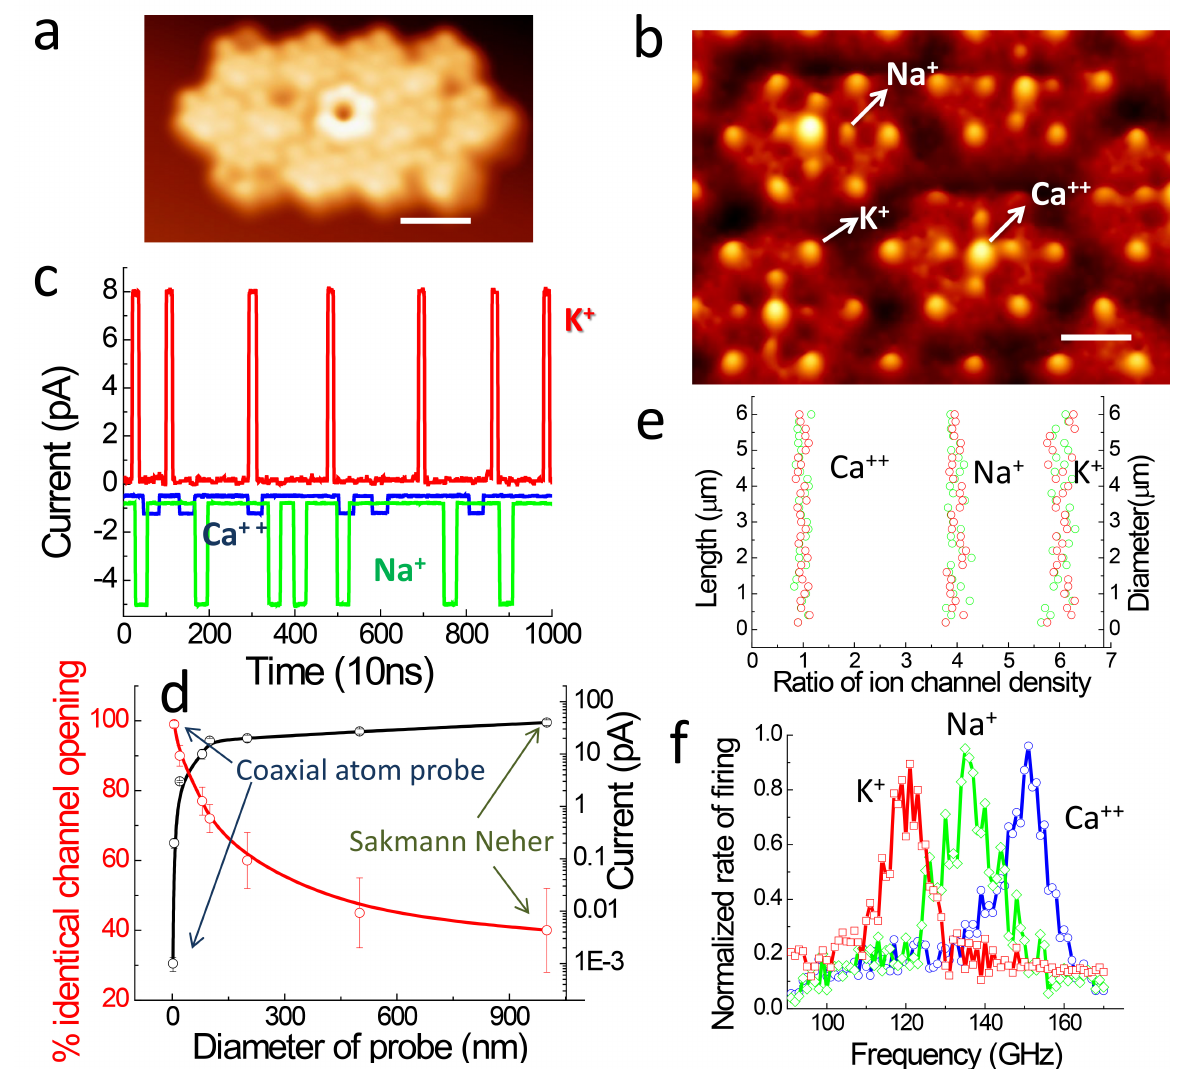
Fig. 4. Imaging & recording of single ion channel. (a) STM image of an isolated membrane captured by rupturing a live neuron cell, at 2.3 V, 6 pA. The scale bar is 7 nm. (b) SDIM image of a membrane captured by scanning a live neuron cell at 3.3 V, 2 pA, 130 GHz. The scale bar is 16 nm. (c) For Na + , Ca ++ and K + ion channels, unitary current amplitude, holding potential –70 mV, coaxial tip Pt had a 5 nm hole (accidental hole gives the best result) at the edge. Probe fixed at the location shown in panel (b). (d) From 23 Na + datasets of panel c, taken by varying probe diameter (n = 8) 1 µ m to a single atom (0.2 nm), how many times a channel remains open for equal time widths, among a random stream of open/close events of ion channels for 8 minutes. Percentage of the opening (black, left) & current peak as a channel opens (red, right). (e) Sixty branches with different lengths (green) and different diameters (red) were chosen, and shifts in the density relation Ca ++ :Na + :K + : 1:4:6 found in panel b are plotted. (f) During natural ion channel Na + (green), Ca ++ (blue) and K + (red) open/close event of panel b, an additional ac signal is applied, the rate of the opening is normalized with respect to the 8MHz maximum